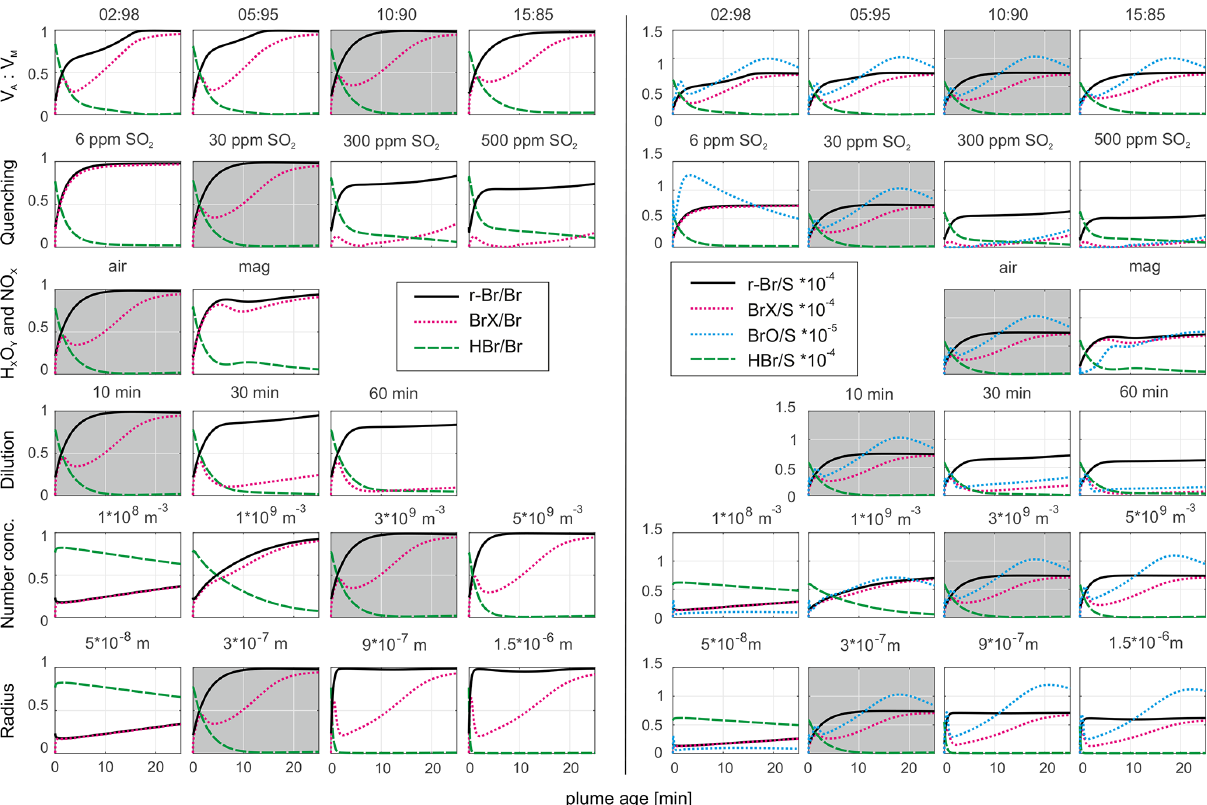
Figure 8. The progression of selected bromine species over a model runtime of 25min related to total bromine (left half) and sulfur (right half) abundances. The best fit to the measurement data from Fig. 7c (10:90; 30ppmv SO 2 ; air; 10min; 3 × 10 9 particlesm − 3 ; r = 3 × 10 − 7 m) is shown using a gray background, and within the specific rows, the one model parameter is varied over different values in order to explore the model output answer to the model input